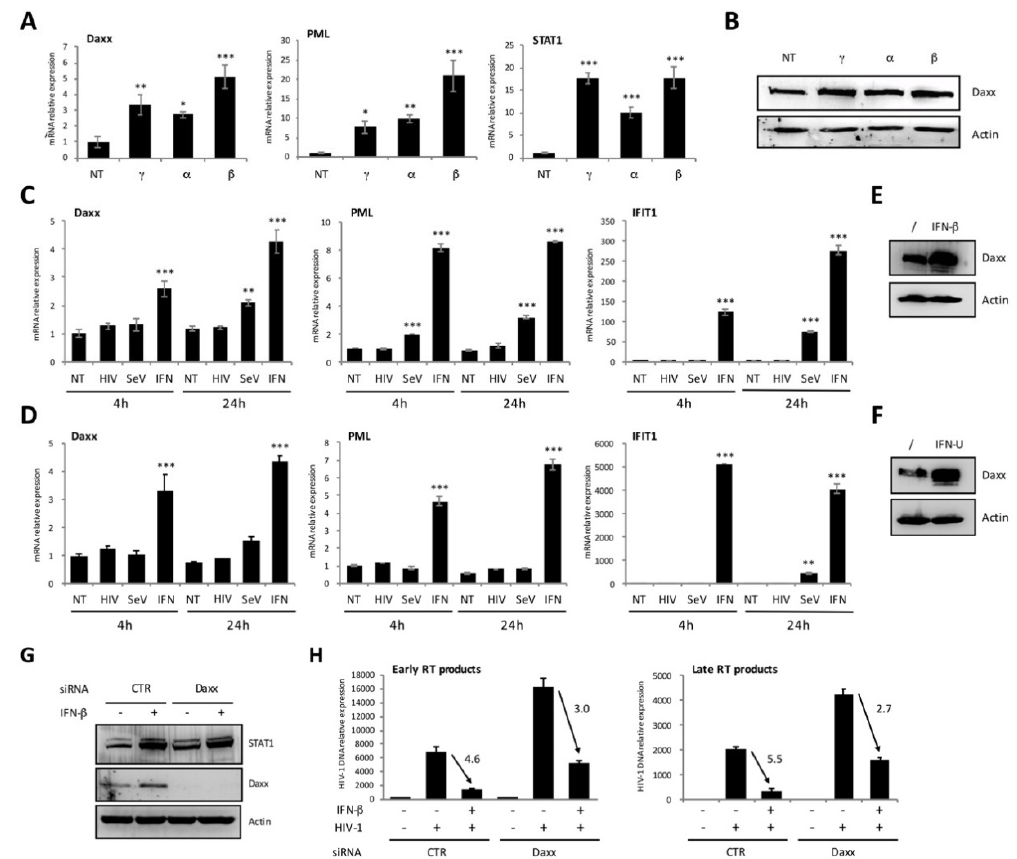
Figure 1. Death domain-associated protein 6 (Daxx) expression is induced by type I and type II interferons (IFNs) and inhibits HIV-1 reverse transcription. ( A , B ) HeLa cells were treated for 24 h with 1000 IU of IFN- α 2, - β , or - γ and the levels of PML and STAT1 expression were assessed by RT-qPCR ( A ), whereas Daxx expression was determined by both RT-qPCR ( A ) and Western blot ( B ); ( C , D ) HeLa (C) or MDTF (D) cells were either treated with 1000 IU of IFN- β , transduced with VSV-pseudotyped HIV-1 (MO1 = 1), or infected with SeV (50 HAU / mL). After 4 or 24 h, the expression levels of Daxx, PML, and IFIT1 were determined by RT-qPCR; ( E , F ) HeLa cells were treated with 1000 IU of IFN- β (E) and MDTF were treated with 200 IU of Universal type I IFN (IFN-U) (F) and the expression of Daxx was evaluated by Western blot 24 h post treatment; ( G , H ) HeLa cells were transfected with irrelevant (CTR) or Daxx-specific siRNA and treated 24 h later with 1000 IU of IFN- β . After 24 h, the expression levels of Daxx and STAT1 were determined by Western blot (G). Then, cells were transduced for 4 h with VSV-G pseudotyped HIV-1 at a MOI of 1, and early and late RT products were quantified by qPCR. The IFN-induced inhibition folds in cells transfected with the CTR or the Daxx-specific siRNA are shown on the graphs (H). All data correspond to means ± SD of three independent experiments. * p < 0.05, ** p < 0.01, and *** p < 0.001 as determined by one-way ANOVA with Bonferroni post hoc test (A, C, D).